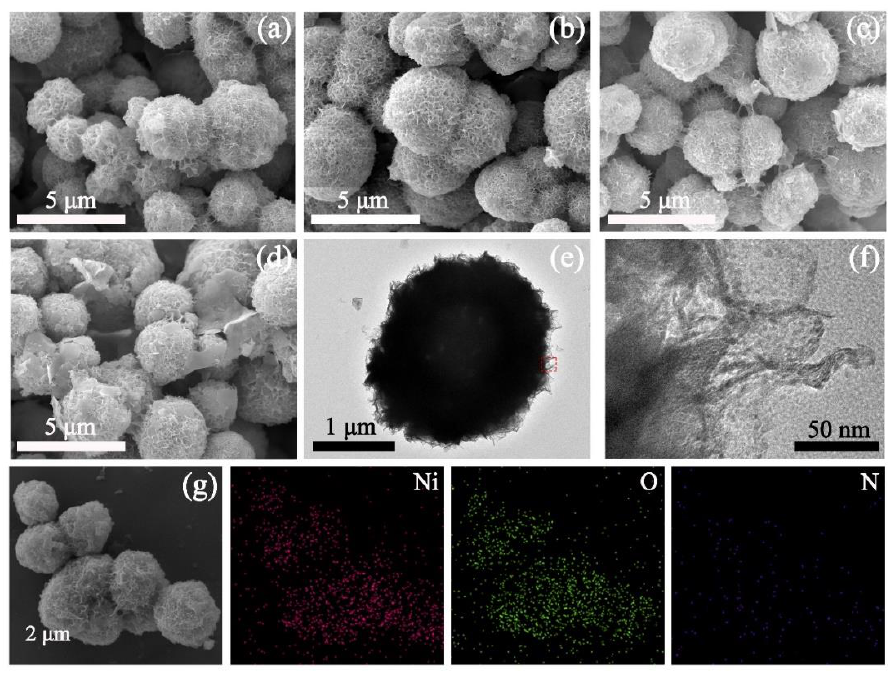
Figure 1. SEM images of ( a ) Ni(OH) 2 -24; ( b ) Ni(OH) 2 -36; ( c ) Ni(OH) 2 -48; ( d ) Ni(OH) 2 -60; ( e ) TEM image; ( f ) HRTEM image of Ni(OH) 2 -36; ( g ) EDS mapping of Ni(OH) 2 -36.